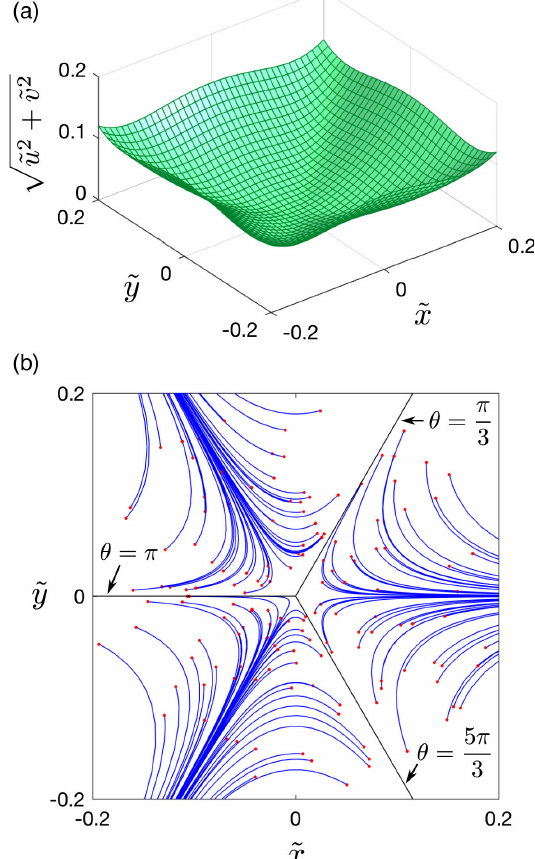
FIG. 2. Center manifold reduction of the dynamics at the origin for Eq. (1) with U 3 ð r; θ Þ . (a) Three-dimensional projection of the approximate center manifold given by Eq. (5). (b) Approximate dynamics on the center manifold, given by Eq. (6). The blue curves are trajectories initiated at the (randomly chosen) initial conditions indicated by red